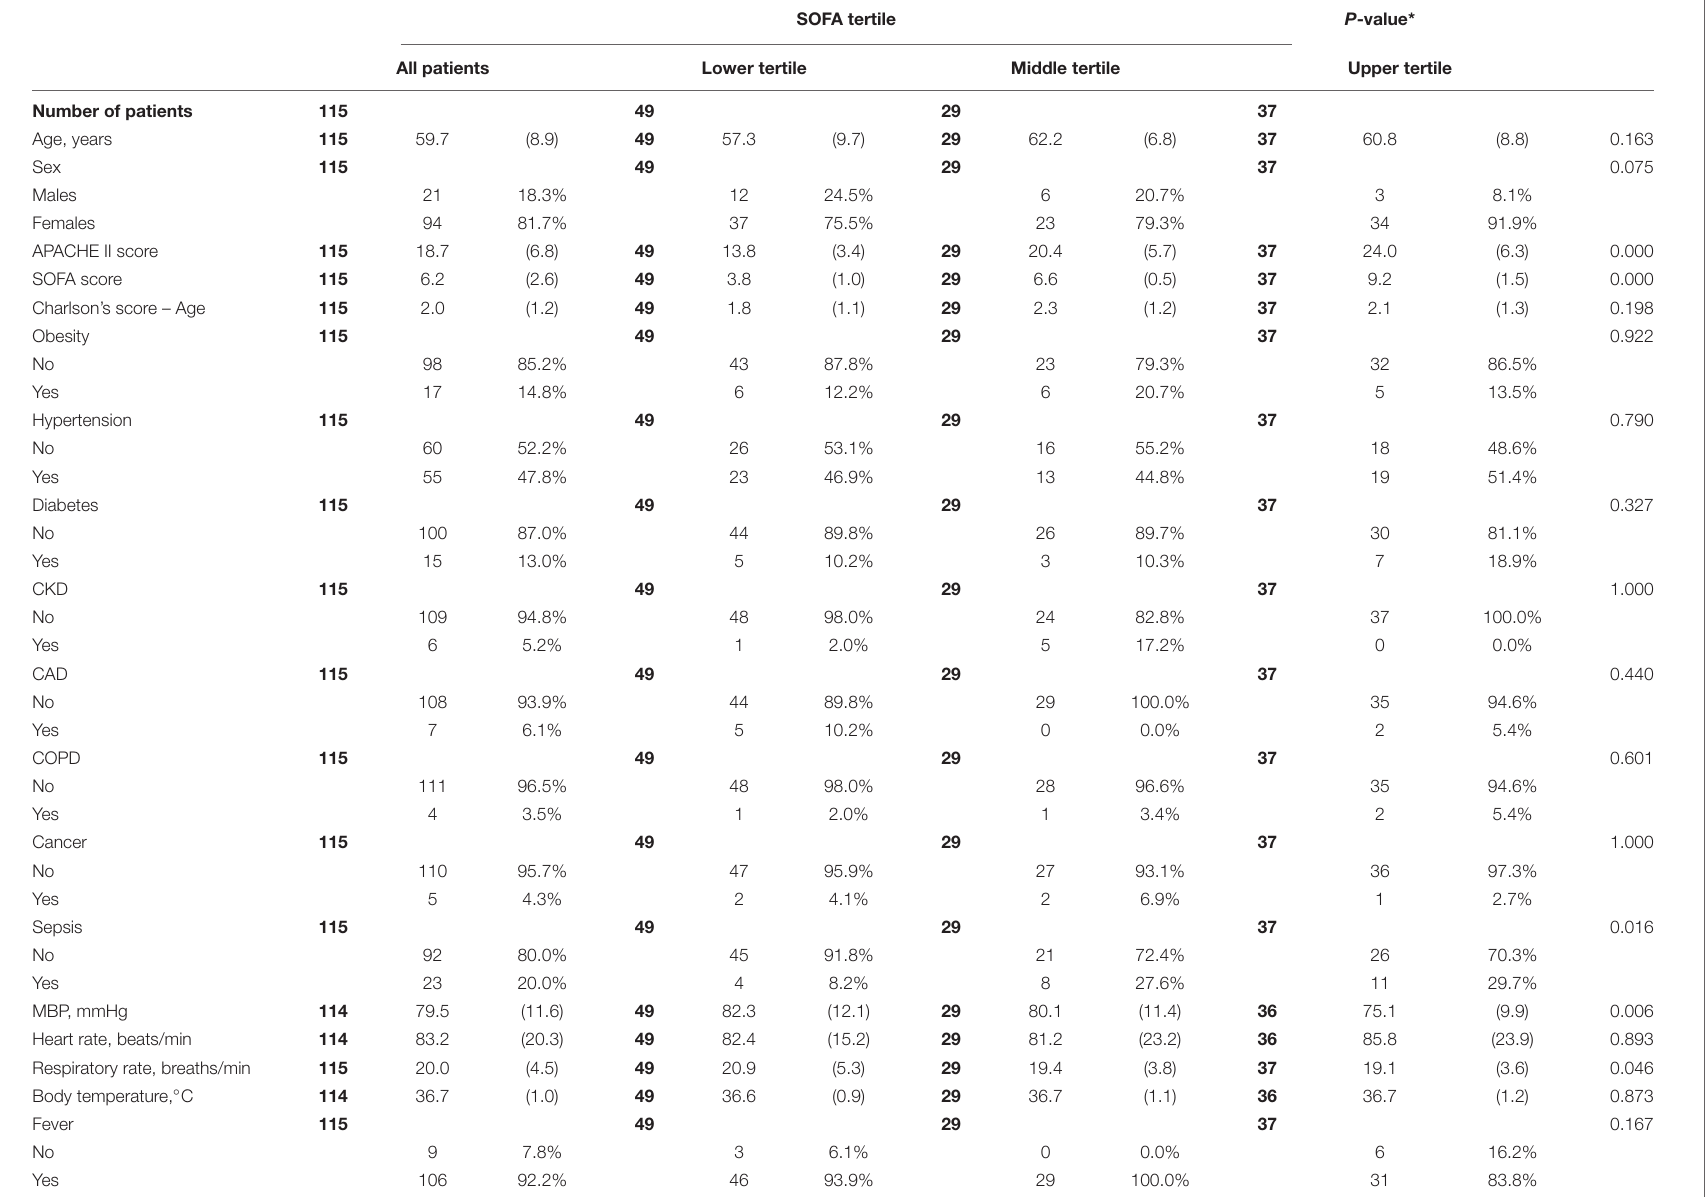
TABLE 1 | Demographical and clinical data of patients according to tertiles of SOFA score at ICU admission. SOFA tertile P -value* All patients Lower tertile Middle tertile Upper